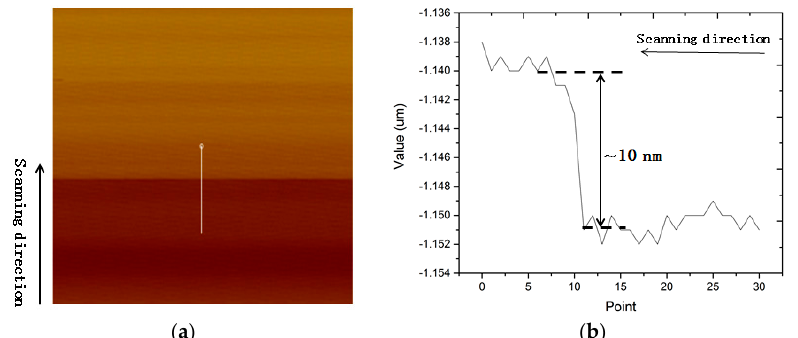
Figure 5. Height information of the AFM cantilever: ( a ) image of the height of the AFM cantilever with a half of excitation and another half without excitation on the SMR; and ( b ) values of the height sensor in the area where the white line in ( a ) lies.